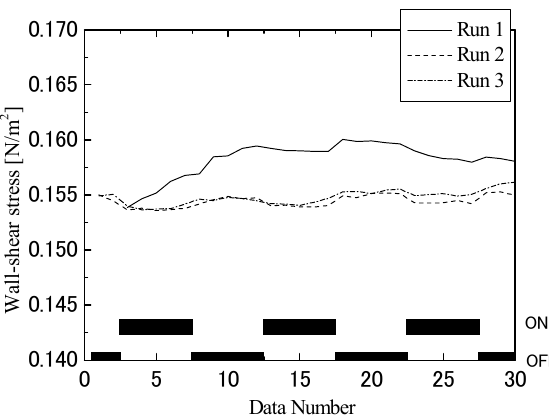
Fig.8 Wall-shear stress by PSJA on/off x D =75mm